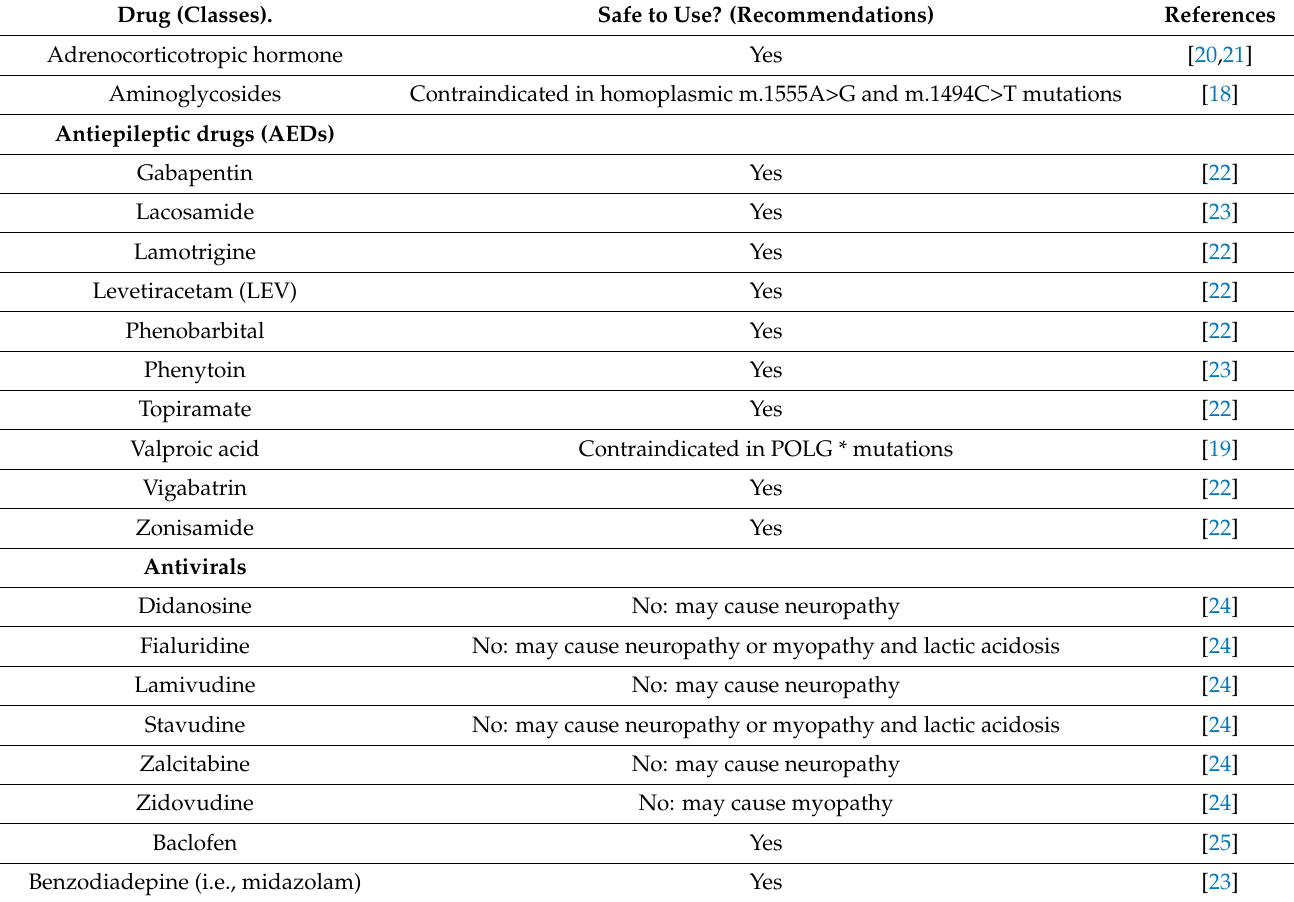
Table 1. Recommendations for safety use of the main drugs and drug classes in mitochondrial patients. Drug (Classes). Safe to Use?